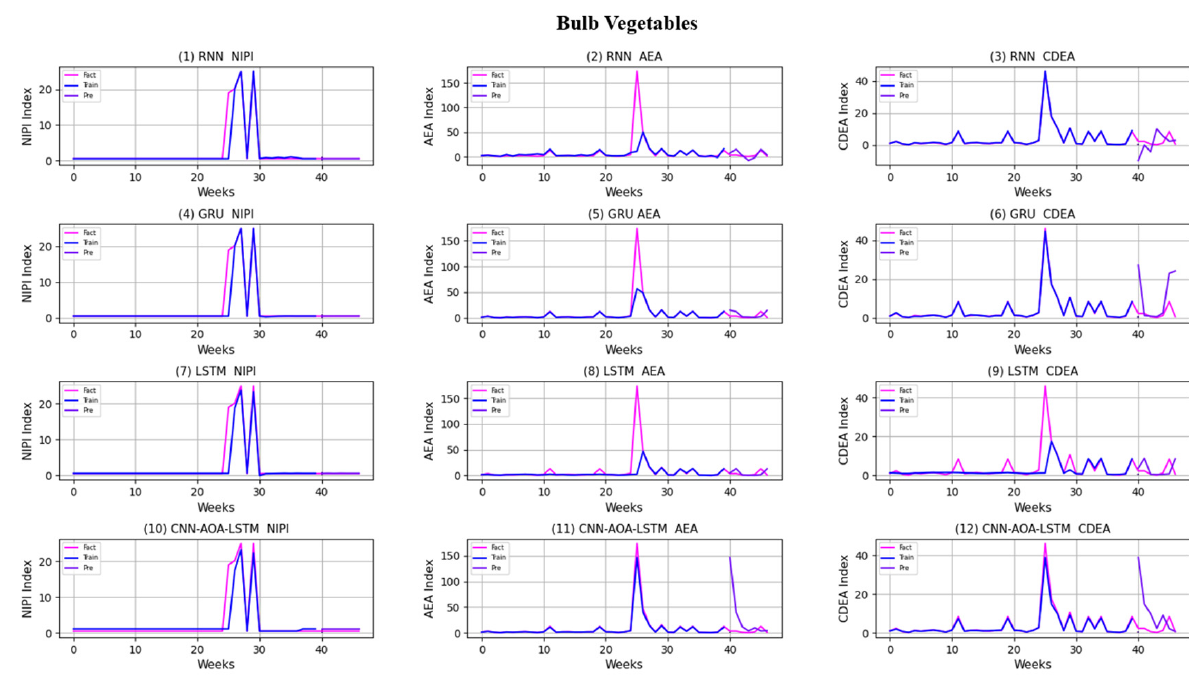
Figure 10. Prediction results of indexes of solanaceous vegetables.